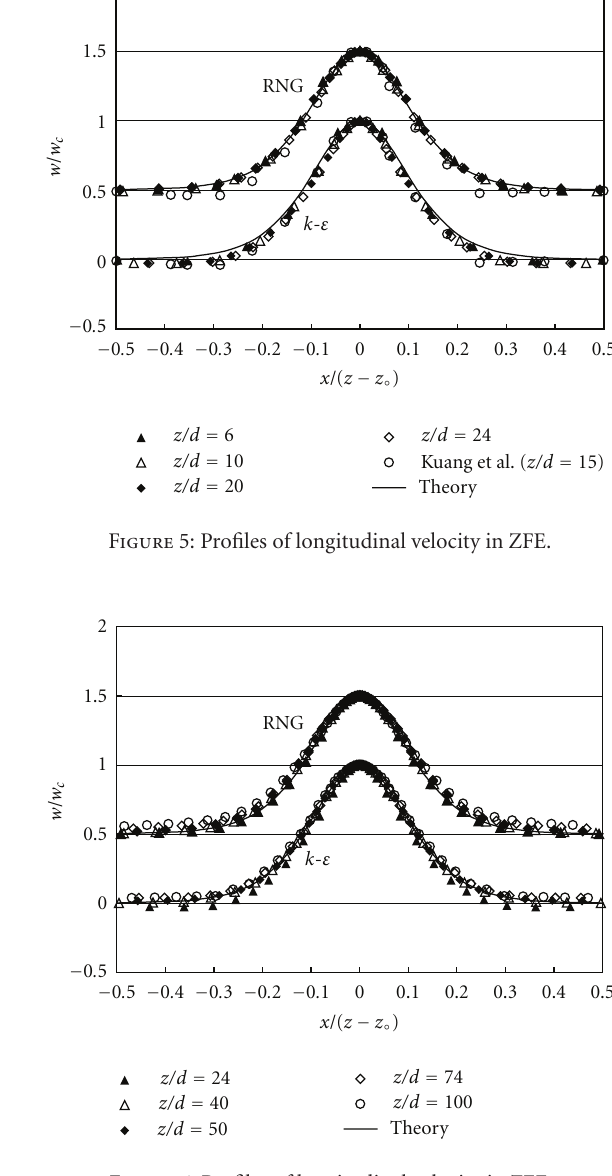
Figure 6: Profiles of longitudinal velocity in